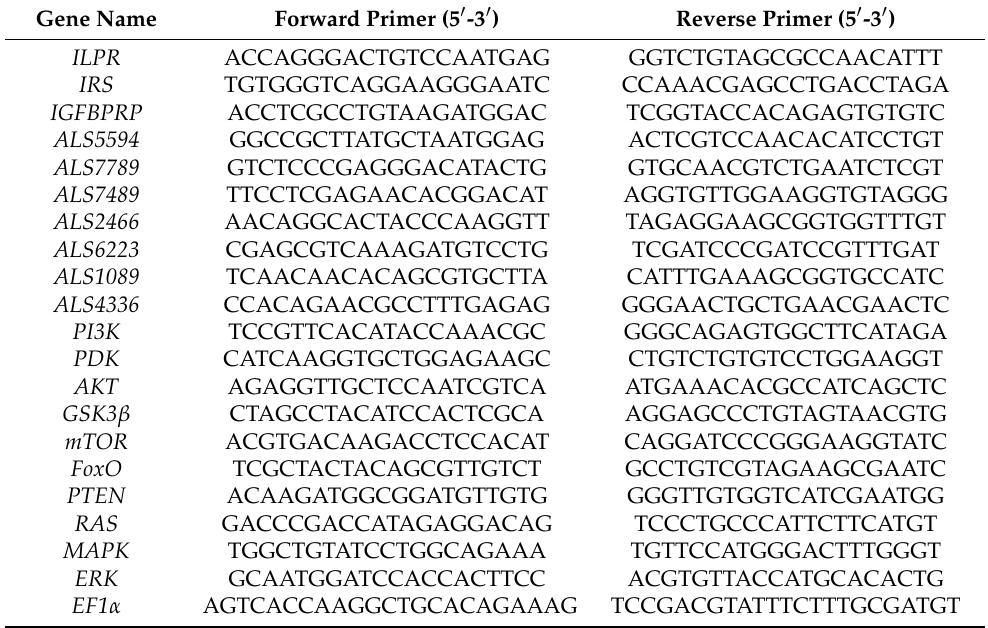
Table 2. Primers used for the real-time PCR in this